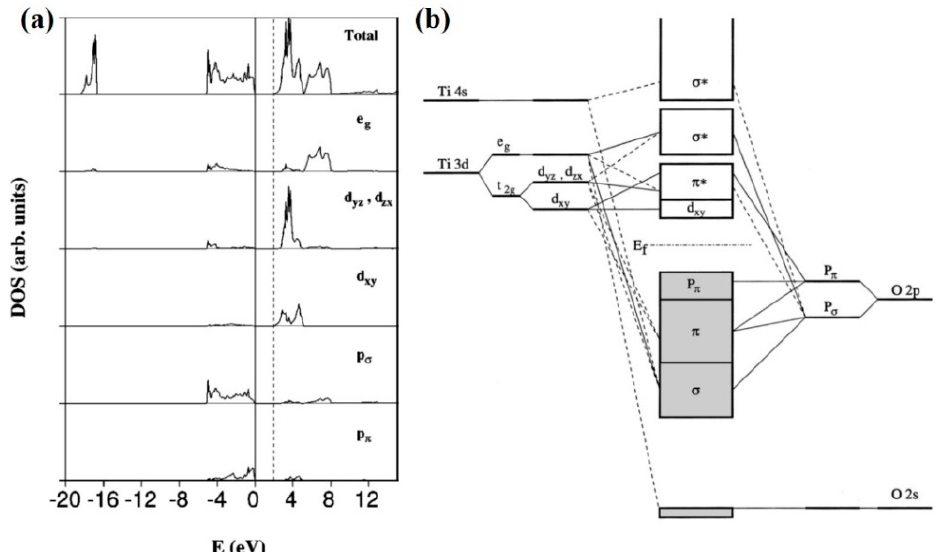
Figure 2. ( a ) Total and projected densities of states (DOS) of the anatase TiO 2 structure and ( b ) molecular orbital bonding structure for anatase TiO 2 [18]. Copyright 2004 The American Physical Society.